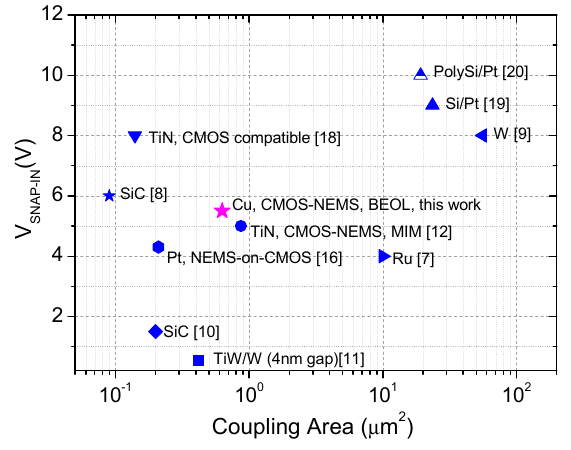
Figure 6. Top-down mechanical switches state of the Art.